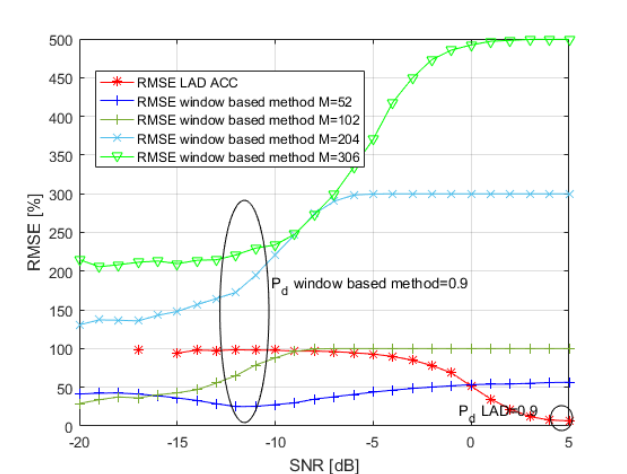
Table 3. Optimal detection window lengths M for signals with different bandwidths (samples / % ].